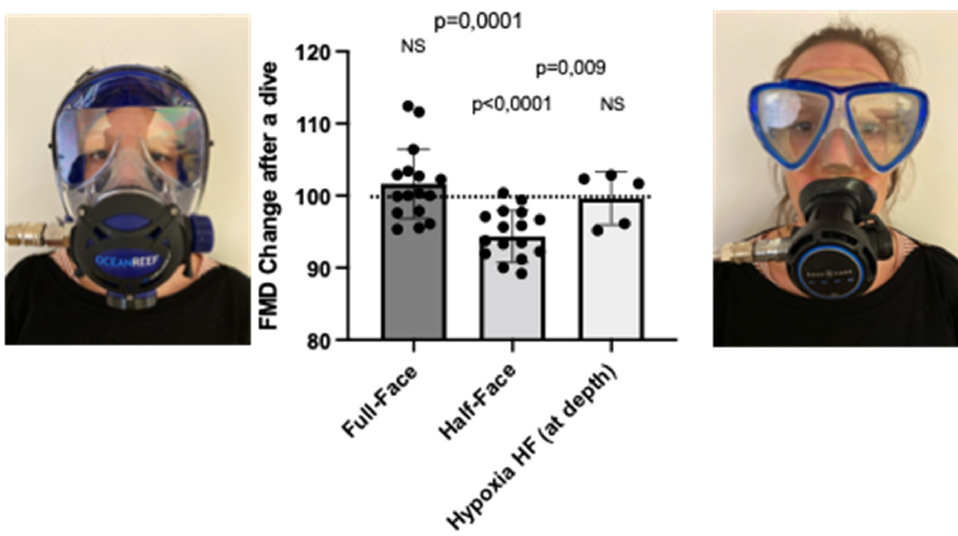
Figure 2. Flow mediated dilation (FMD) changes after a dive (10 m for 20 min) either wearing a full-face mask or a classical “half-face” diving mask ( n = 16). In hypoxic dives ( n = 5), subjects were breathing a gas mixture providing 0.16 ATA of PO 2 at depth. FMD changes are expressed as % of predive values, every diver acting as his own control. Results are expressed as percentage (mean ± SD); NS = nonsignificant.